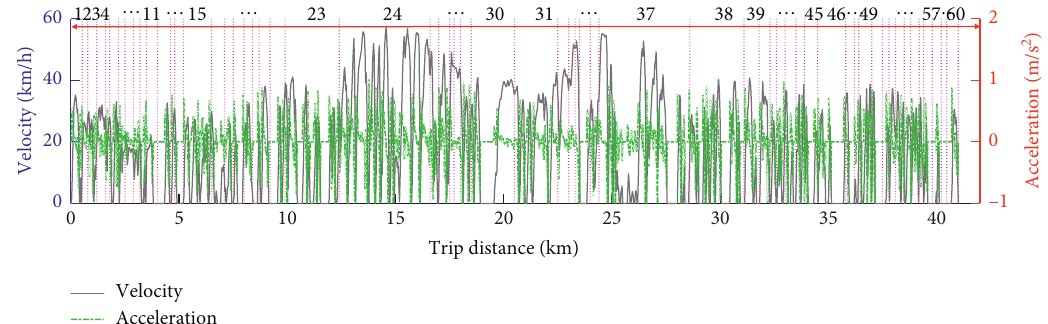
Figure 3: The partition method for a measured driving